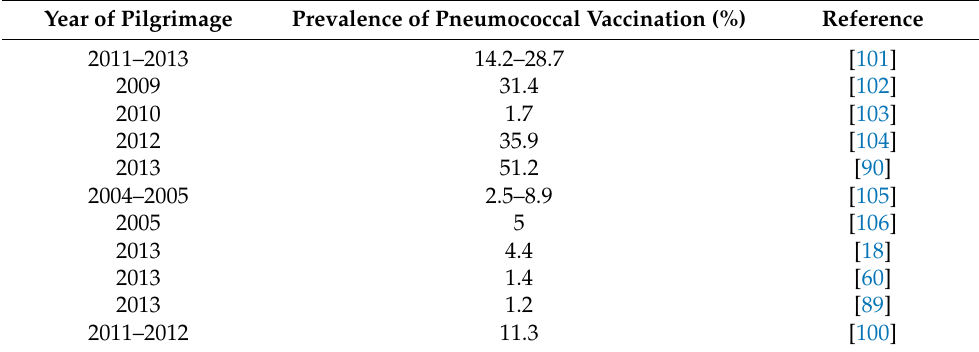
Table 4. Pneumococcal vaccination rates in Hajj